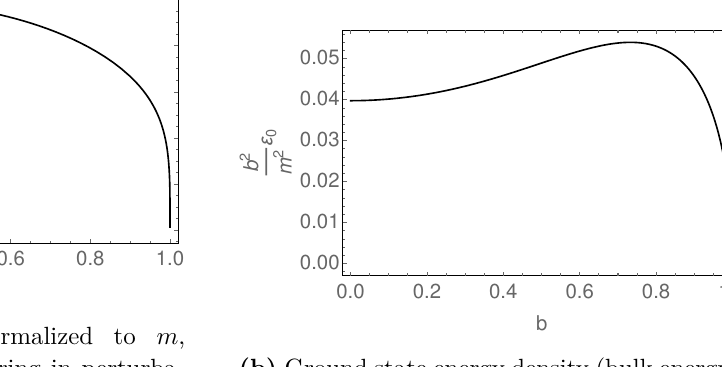
normalized with respect to m 2